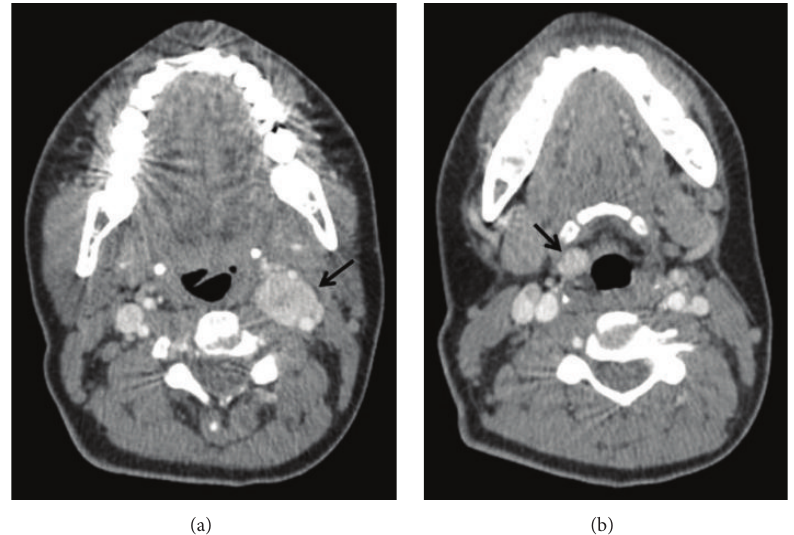
Figure 2: Axial contrast enhanced computed tomography demonstrates vascular mass (arrow) at left carotid bifurcation (a). Right supraglottic, well defined laryngeal mass (arrow) is seen in lower level contrast enhanced computed tomography image